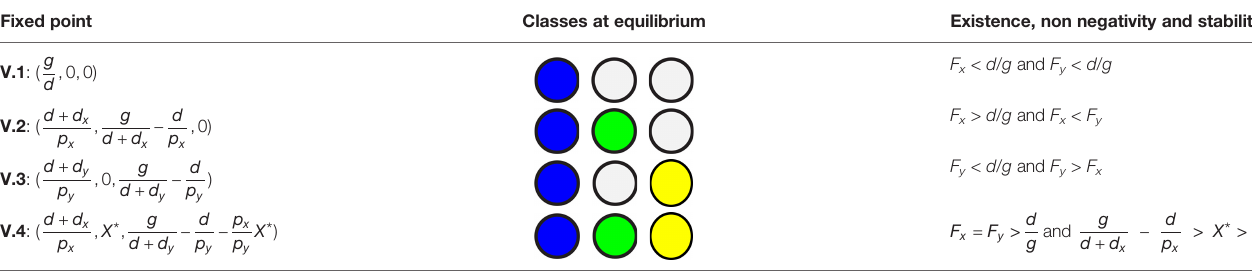
TABLE 1 | Properties of the solutions of model V.